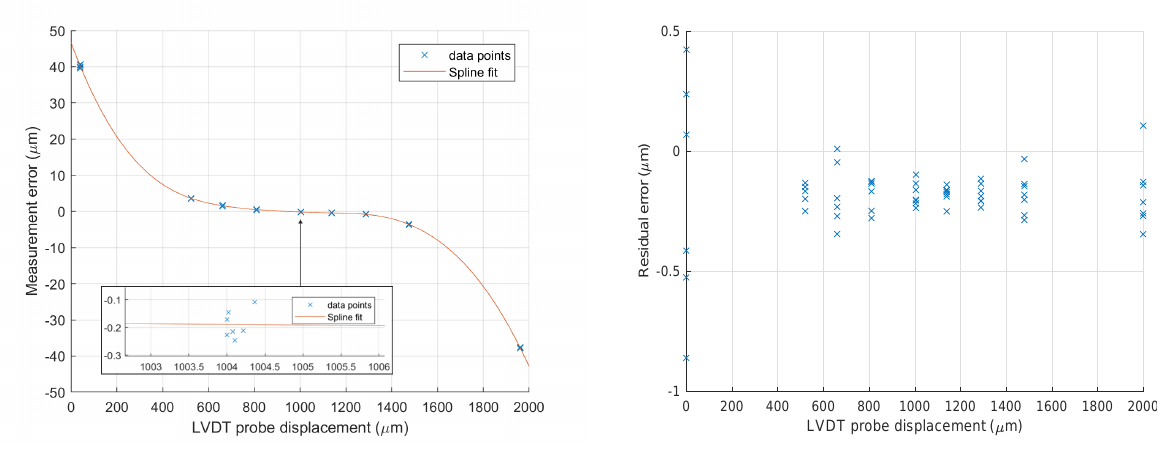
Figure 2: LVDT error at full scale, ± 1000 (cid:181) m displace- ment relative to centre position.